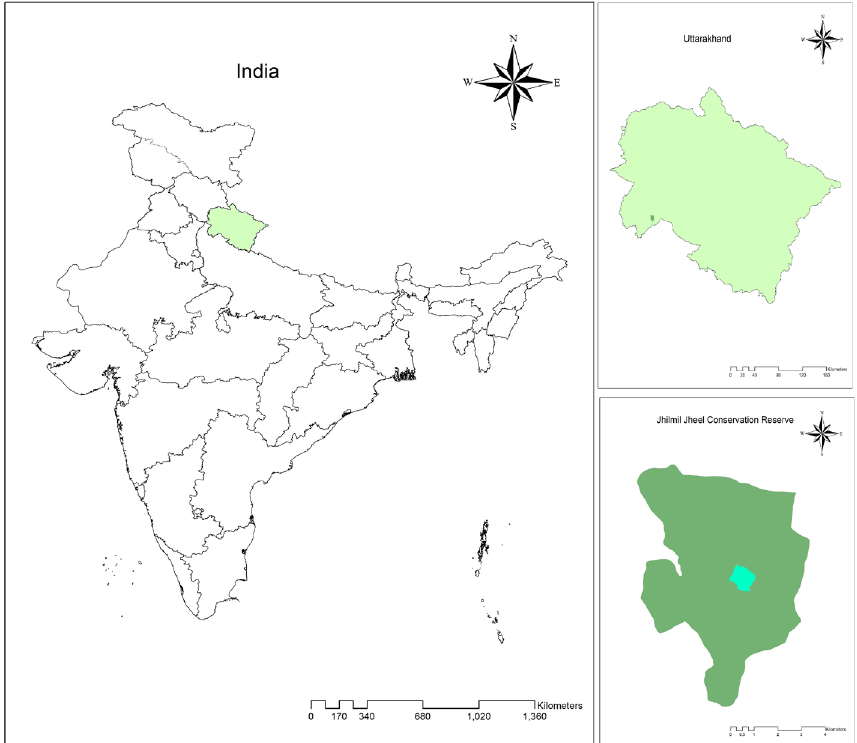
Figure 1. Map showing the location of Jhilmil Jheel Conservation Reserve in Uttarakhand.